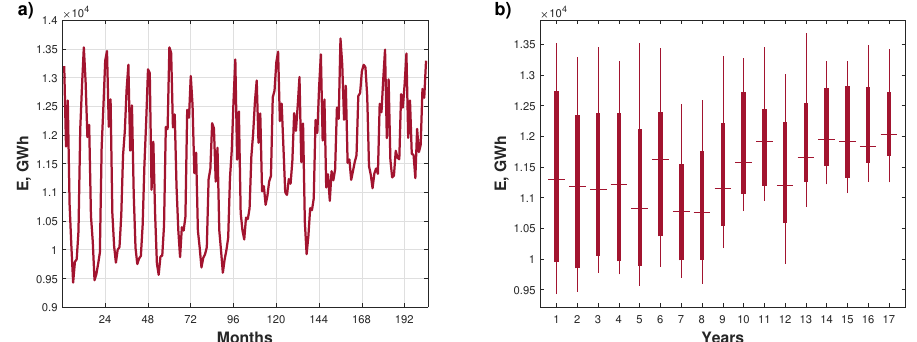
Figure 1. Graph of the monthly electricity demand time series for Poland ( a ) and the box diagram showing the medians and annual dispersions ( b ).